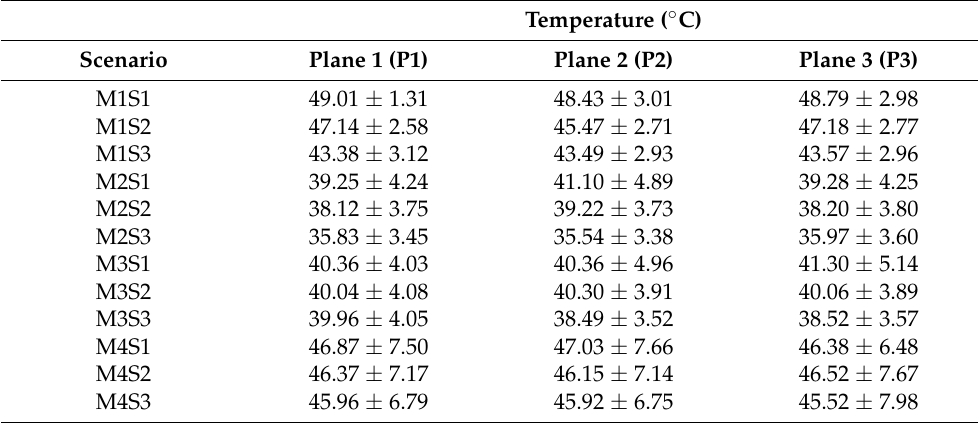
Table 6. Average temperature values obtained for each simulated scenario.